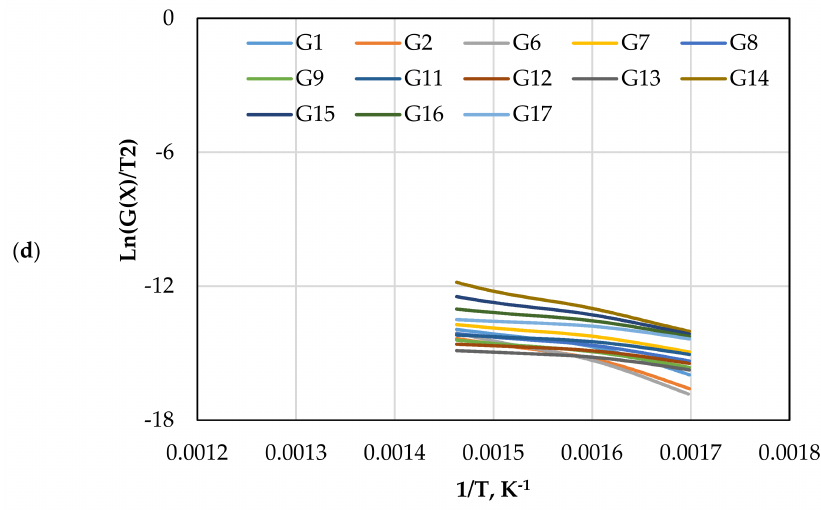
Figure 7. The CR method plots for CO 2 gasification at different olivine loadings: ( a ) 0 wt.%, ( b ) 5 wt.%, ( c ) 10 wt.%, and ( d ) 15 wt.%.